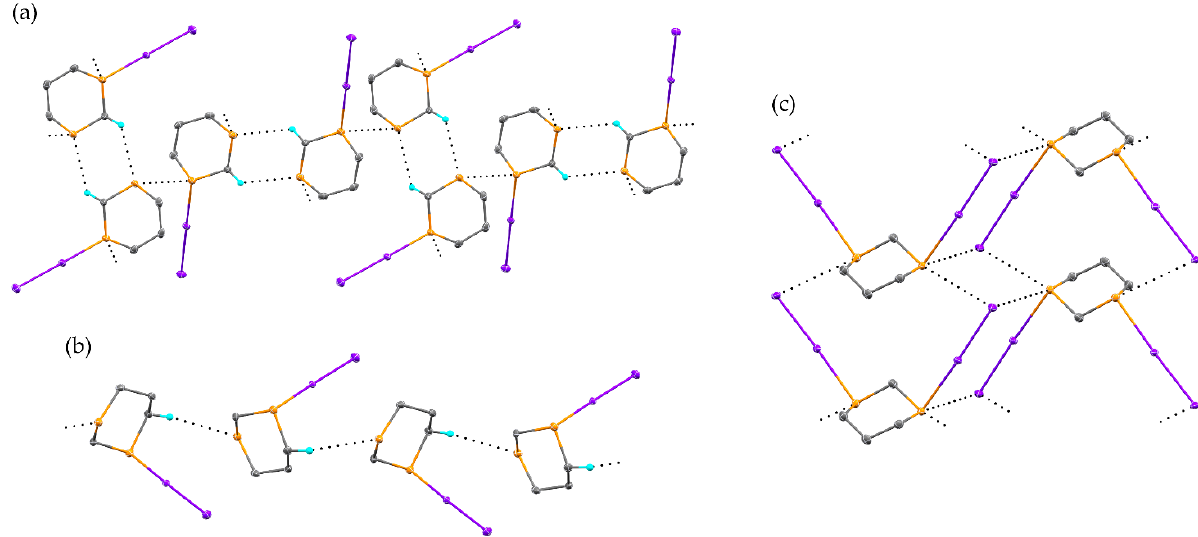
Figure 1. The solid-state structure of 1 ( a ), 2 ( b ), and 3 ( c ). Carbon atoms are gray. Sulfur atoms are yellow. Iodine atoms are purple. Hydrogen atoms are cyan. Intermolecular interactions are shown as black dotted lines. Only hydrogen atoms involved in the indicated intermolecular interactions are shown for clarity. Atomic displacement ellipsoids are shown at the 50% probability level.